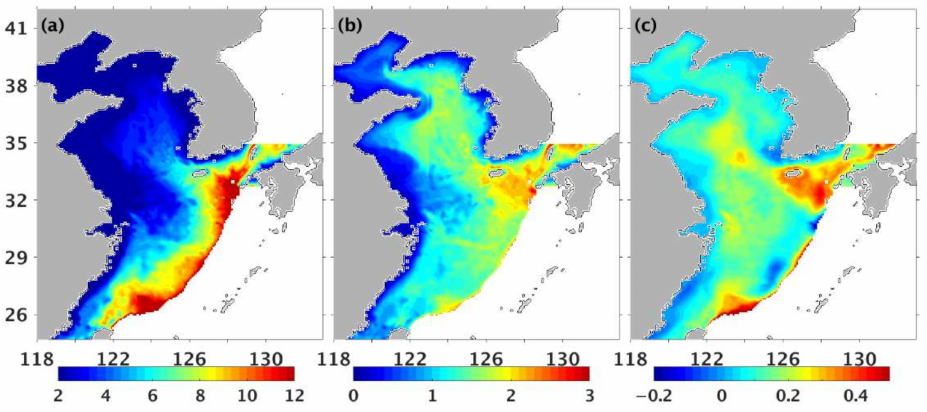
Figure 3. ( a ) Annual mean ( × 10 9 J m − 2 ), ( b ) standard deviation ( × 10 8 J m − 2 ), and ( c ) linear in- creasing trend (W m − 2 ) of the OHC in the BYECS over the 1993–2019 period from the JCOPE2M reanalysis